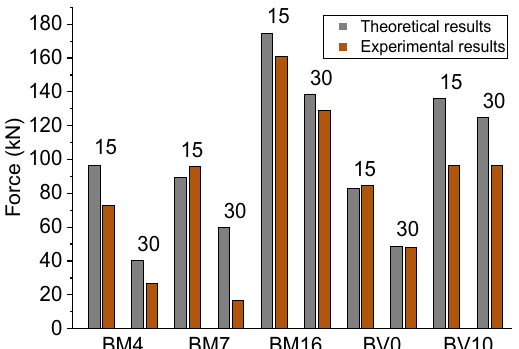
Figure 14. Comparison between theoretical and experimental